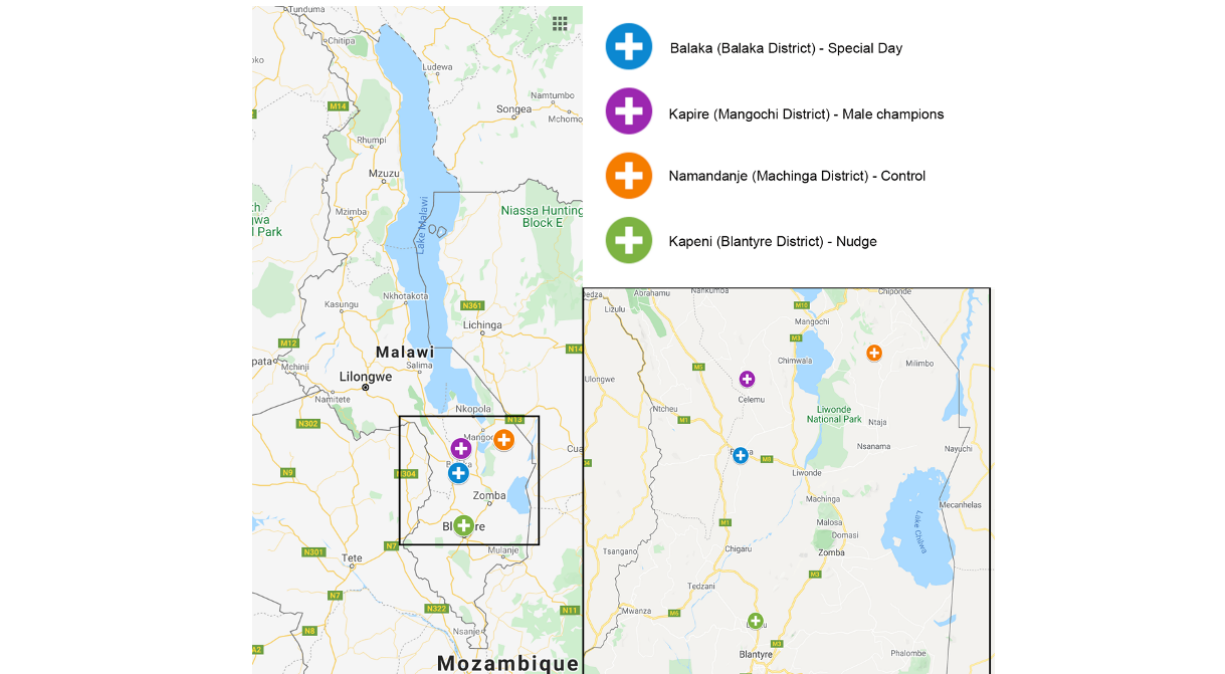
Figure 3. Geographical location of the 4